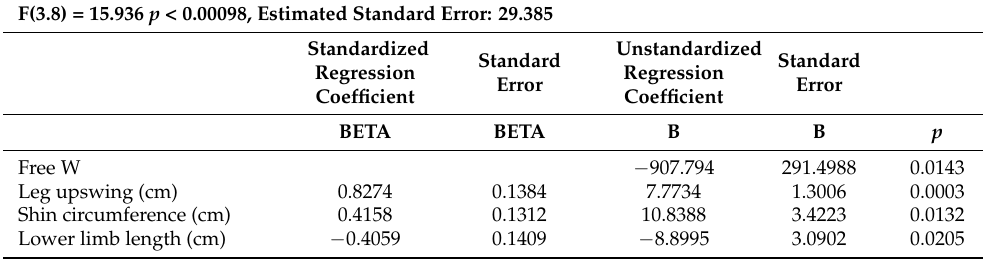
Table 8. Summary details of lambda ridge regression from the 1st study stage for male participants; dependent variable = ranking points.